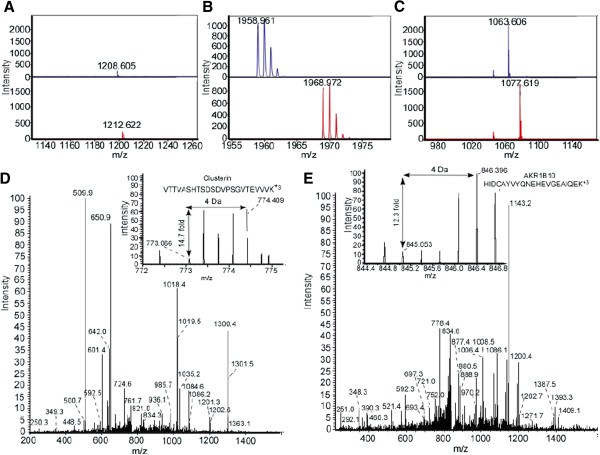
Labeling of 6-10B cells with2H4-L-lysine and13C6 15N4-L-arginine. 6-10B cells were cultured in DMEM containing 2H4-L-lysine and 13C6 15N4-L-arginine or conventional L-lysine and L-arginine as described in the Materials and Methods. A, the peptide VEVTEFEDIK has a charge state of 1+ and contains one lysine; B, the peptide GHYTEGAELVDSVLDVVR has a charge state of 1+ and contains one arginine. C, the peptide LRQPFFQK has a charge state of 1+ and contains one lysine and one arginine. The peaks marked with blue and red represent the light isotope signal and the heavy isotope signal, respectively. Representative MS/MS and MS spectra from clusterin (D) and AKR1B10 (E). The inset shows the relative ratio of heavy to light versions of each precursor ion.